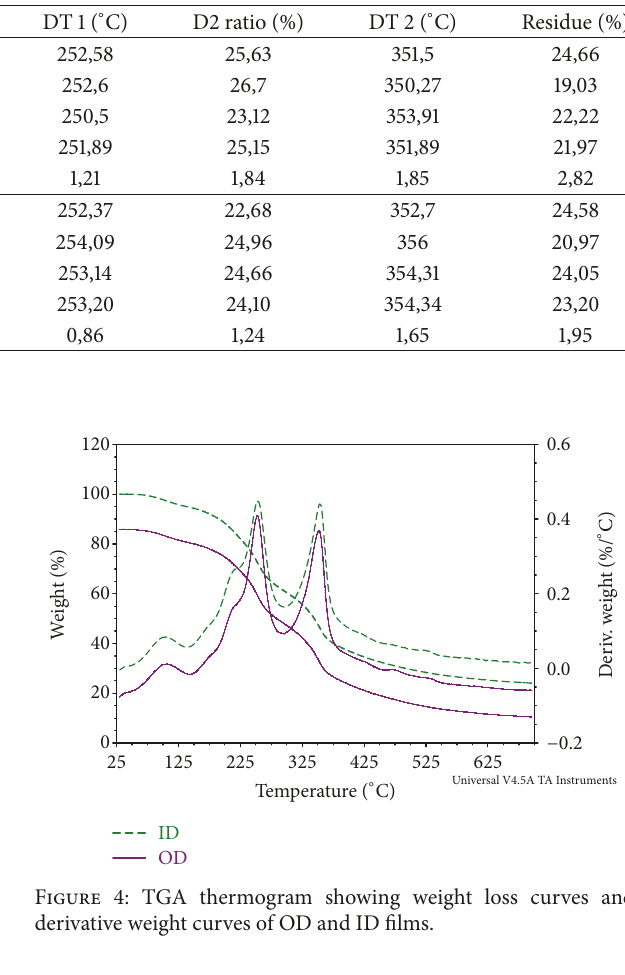
Table2:TGAthermogramshowingdecompositionrateoftheOWFs:moistureloss,decompositionratio1,decompositionratio2andresidue and the maximum temperatures related to the thermal events.